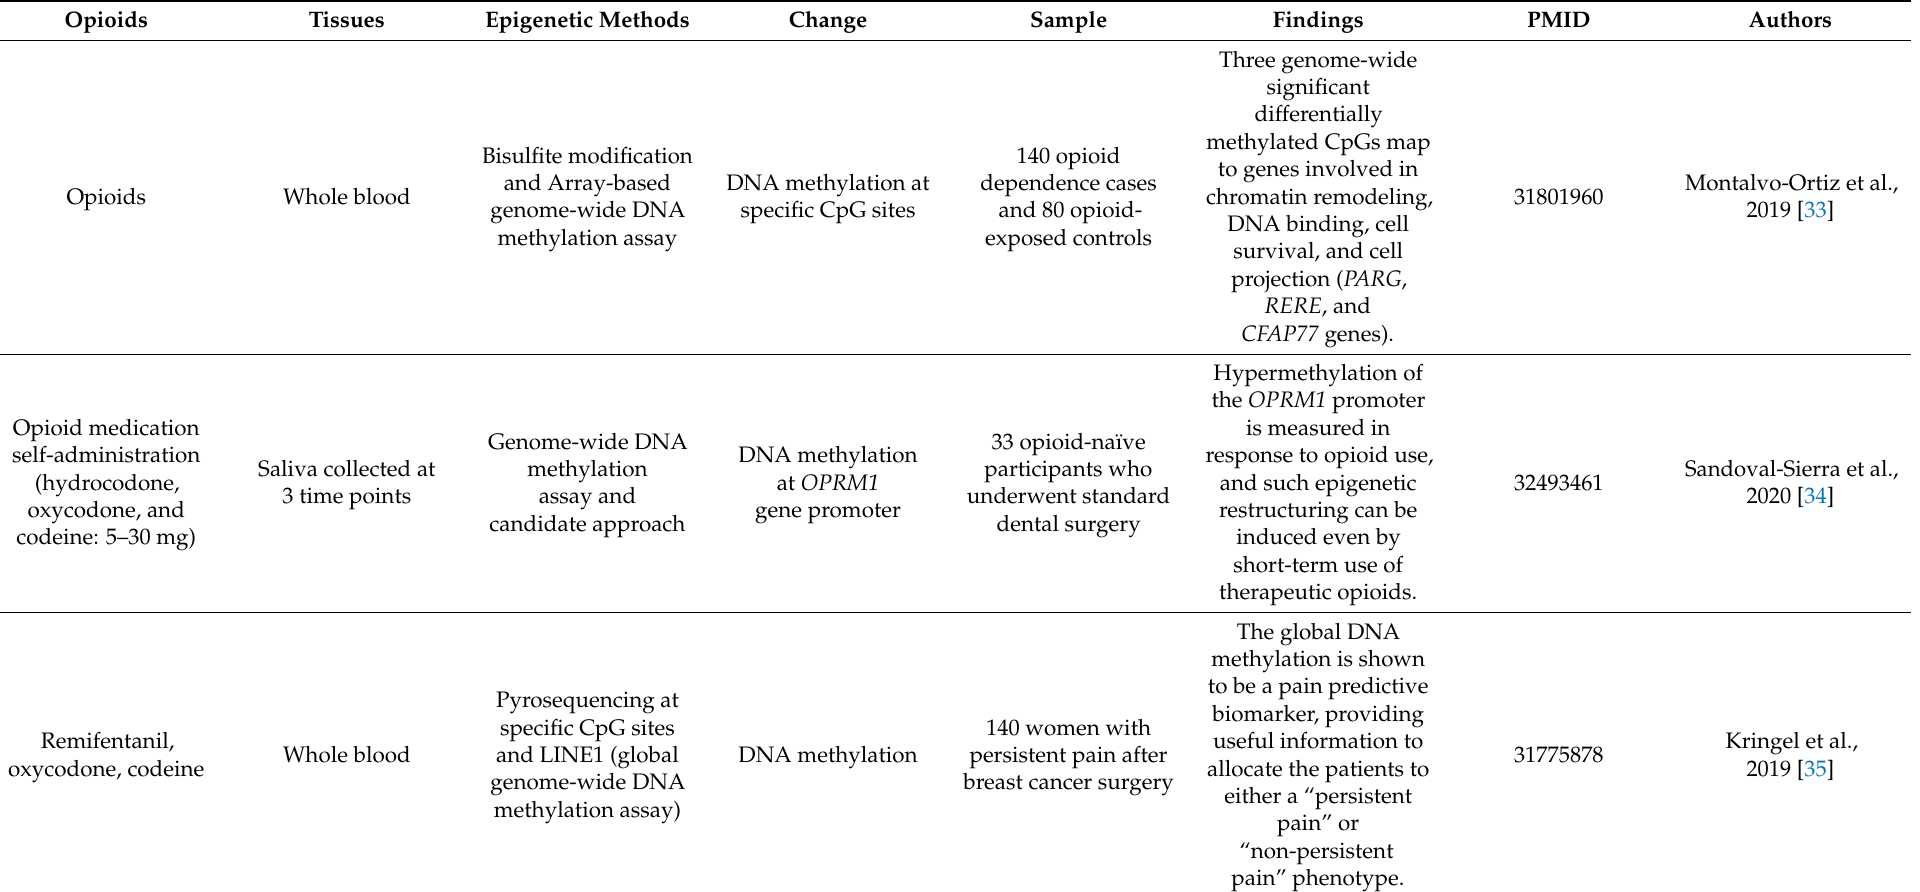
Table 2. Epigenetic changes after prescribed opioid exposure in